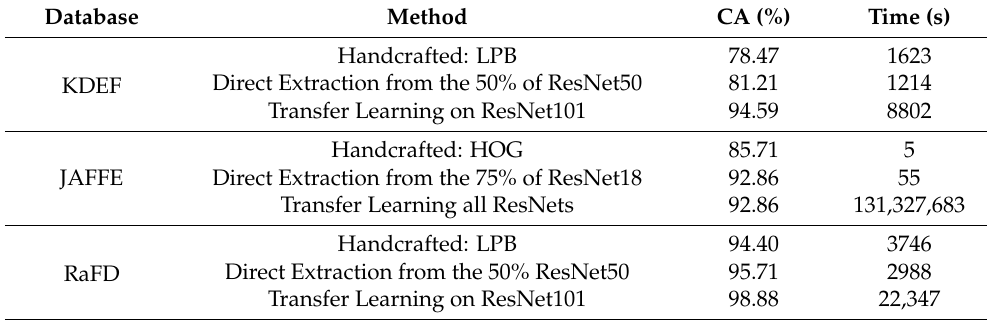
Table 9. Summary table of classification accuracy and total time results per method and database.